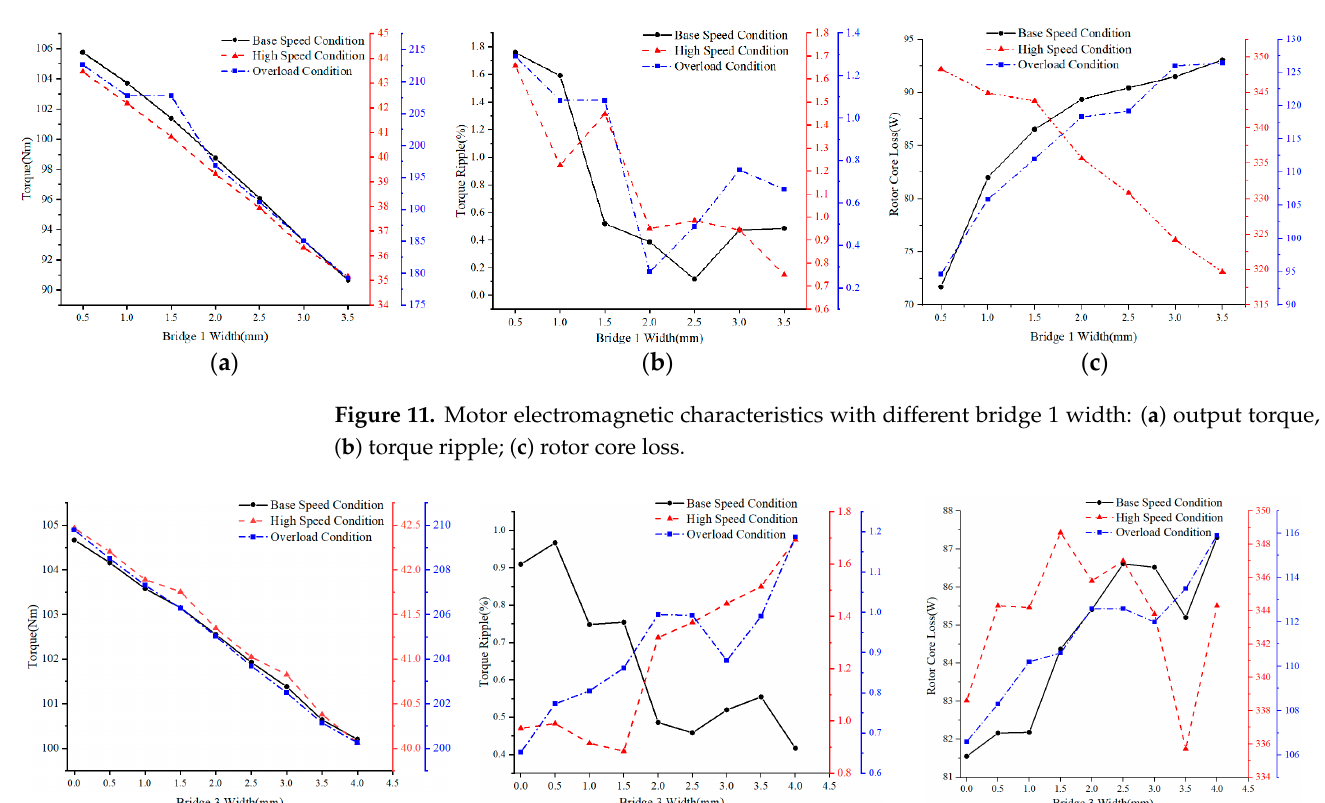
tions: ( a ) rotor maximum von Mises stress, ( b ) rotor maximum deformation quantity.